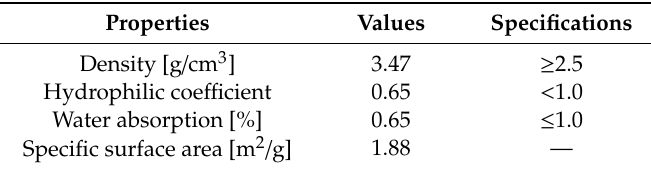
Table 3. Physical properties of steel